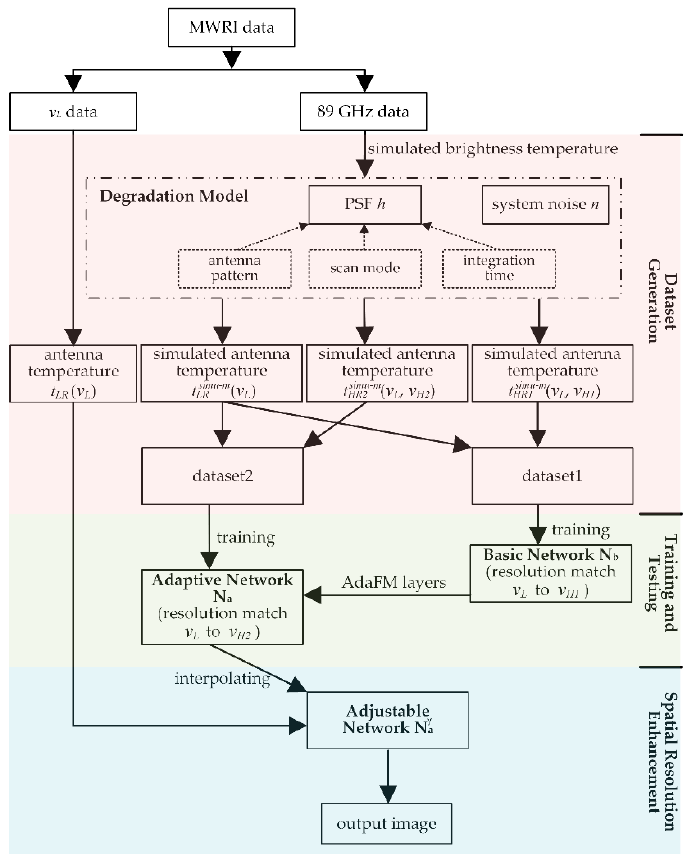
Figure 6. The flowchart of the ASRM framework.